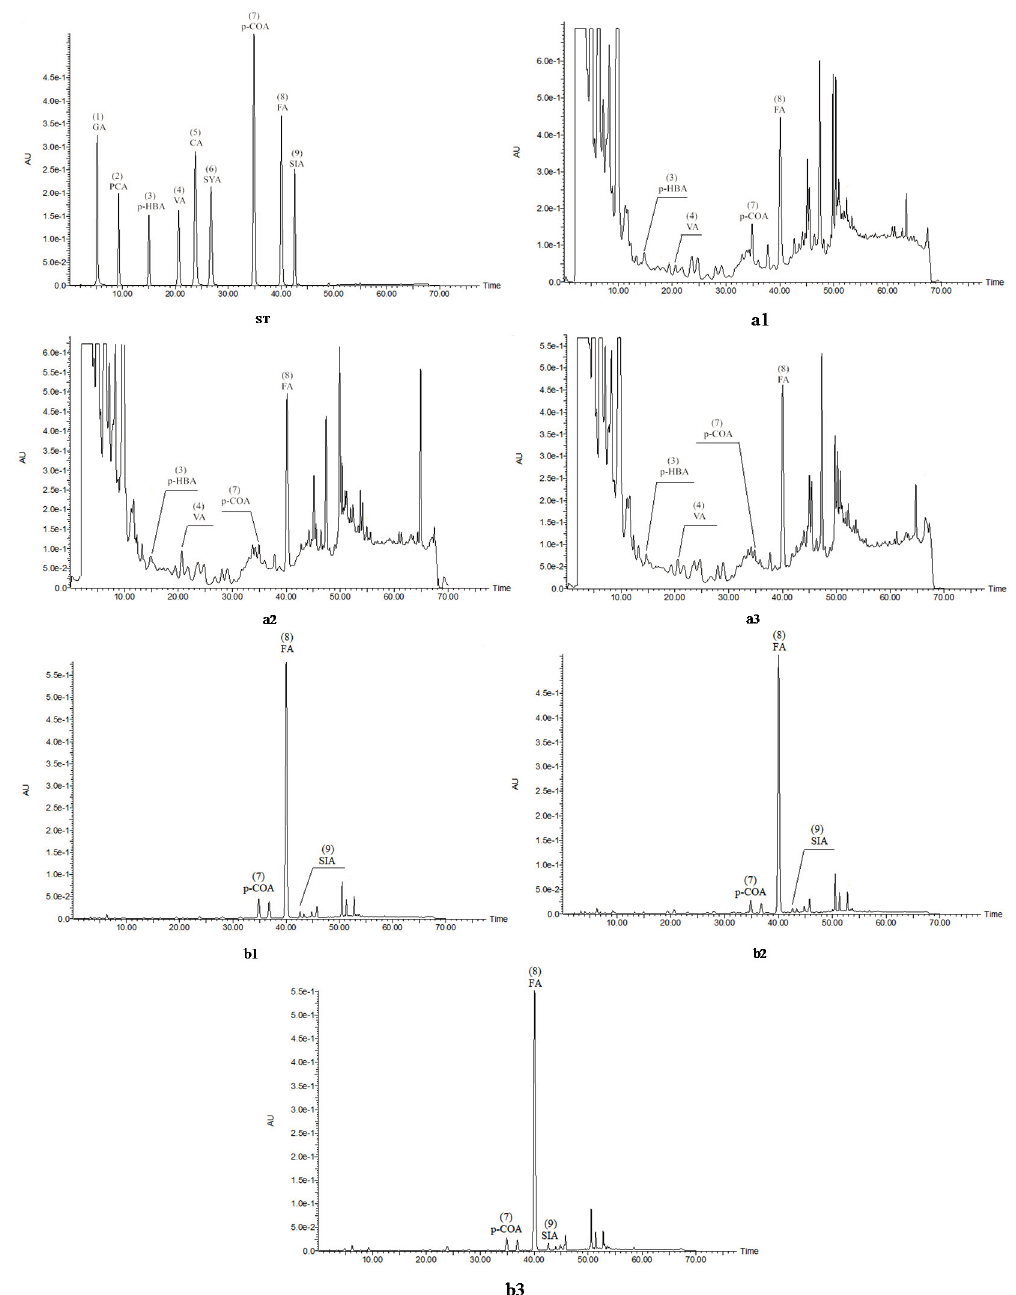
Figure 3. HPLC chromatograms of soluble-free ( a ) and insoluble-bound phenolic extracts ( b ) from Öelands hvede ( 1 ), Indigo ( 2 ), and Konini ( 3 ) bread samples at 280 nm. ST, phenolic acid standards: ( 1 ) gallic acid, ( 2 ) protocatechuic acid, ( 3 ) p- hydroxybenzoic acid, ( 4 ) vanillic acid, ( 5 ) caffeic acid, ( 6 ) syringic acid, ( 7 ) p- coumaric acid, ( 8 ) ferulic acid, and ( 9 ) sinapic